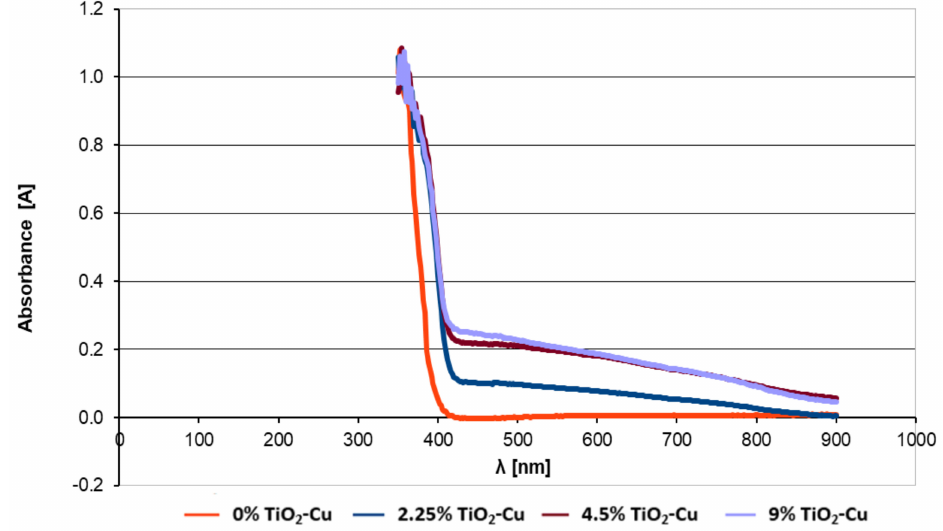
Figure 5. UV-Vis optical absorption spectra collected for paint containing different concentrations of copper-doped TiO 2